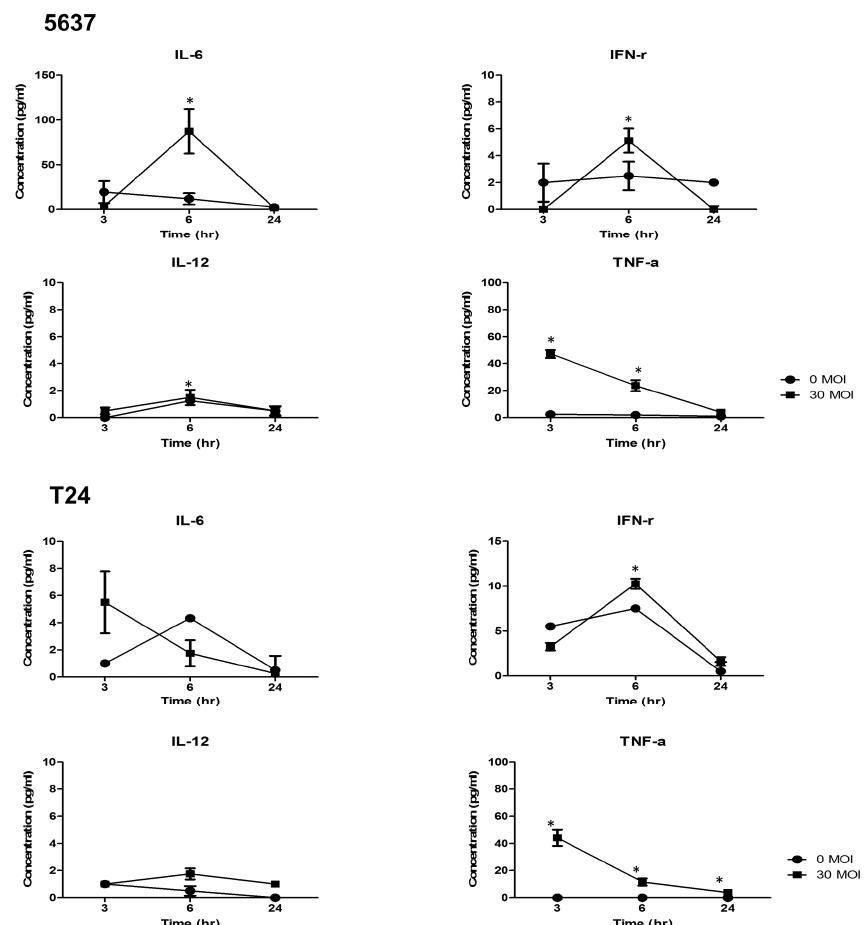
Figure 2. Concentrations of cytokines after BCG treatment of bladder cancer-on-a-chip. Changes of cytokines (IL-6, IFN- γ , IL-12, TNF- α ) before and after BCG 30MOI treatment according to time periods in 5637 and T24 cells. We decided that the appropriate measurement time to evaluate immune reaction was 6 h after treatment at bladder cancer-on-a-chip.* indicates p < 0.05. BCG Treatment We first evaluated the migration effects of PMA and LPS using a Transwell migration assay. PMA promoted the differentiation and migration of THP-1 cells in a dose-depend- ent manner; migration of THP-1 cells was potentiated by 20 ng/mL PMA (Figure S4). We also evaluated the migration effects of PMA and BCG on bladder cancer on-a-chip using 5637 cells. The migration rates of THP-1 cells after treatment with BCG at 30 MOI were potentiated by PMA stimulation, although the effects of BCG were minimally increased without PMA stimulation. Therefore, 25 ng/mL was an appropriate concentration of PMA for use in the BCOC (Figure S5). We evaluated the chemotaxis of monocytic THP-1 cells in the permeable membrane of BCOC after BCG treatment according to the THP-1 cell number (Figure S6). Increasing the number of THP-1 cells in a chip to 2 × 10 4 and 5 × 10 4 significantly increased the fold